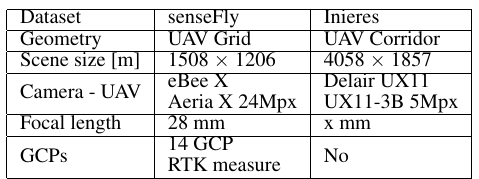
Table 2. Dataset description - The sensFly and the Inieres 3.2 The UX11 and sensFly dataset